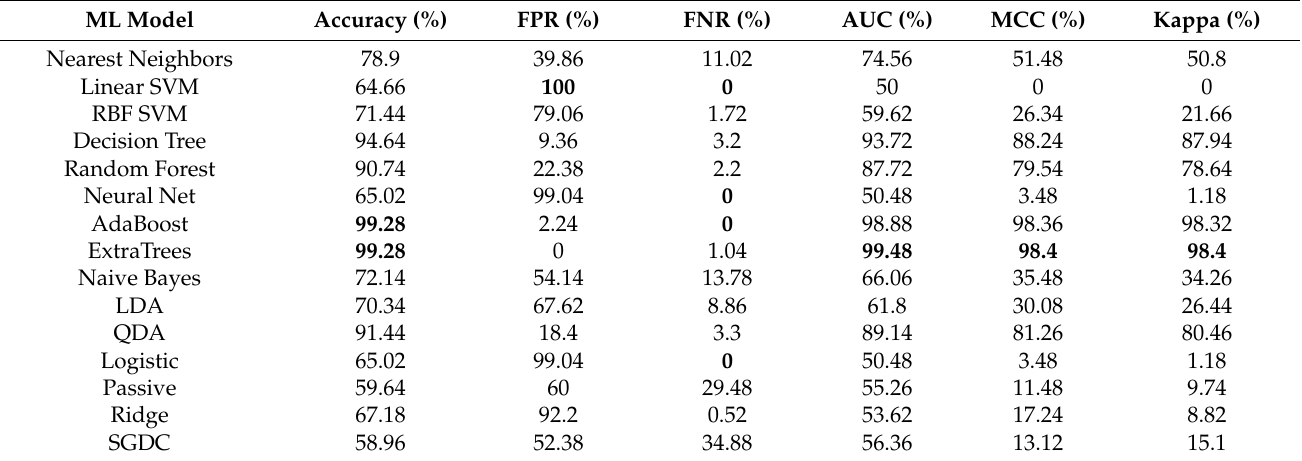
Table 6. The results of ablation study: performance of the proposed model using different final stage ML classifiers. Best values are shown in bold.